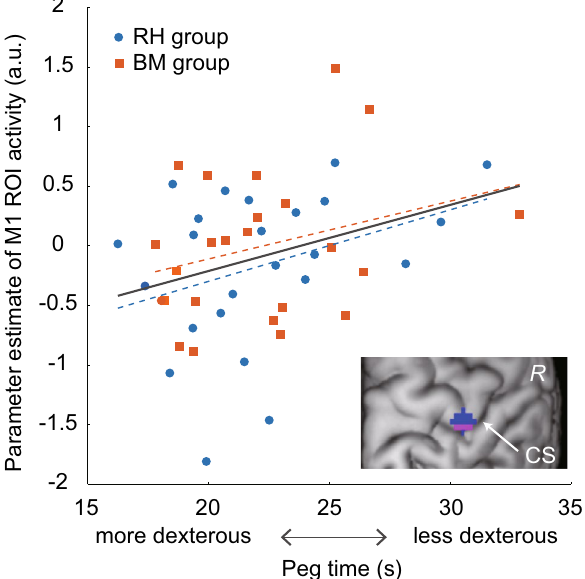
Figure 4. Relationship between the parameter estimate of ipsilateral M1 activity (a.u.; vertical axis) and the peg time (horizontal axis) across 48 older adults. The pink area in the right bottom panel indicates the ipsilateral M1 cluster in which the activity was positively correlated with the peg time. The parameter estimate was extracted from the M1 ROI (blue and pink areas in the right bottom panel). The orange squares represent individual data obtained from the BM group, and the orange dashed line indicates a regression line fitted to the data. The blue dots indicate individual data from the RH group, and the blue dashed line indicates a regression line fitted to the data. The grey solid line indicates a regression line fitted to all the data obtained from both groups. a.u. arbitrary unit, BM bimanual, CS central sulcus, R right hemisphere, RH right